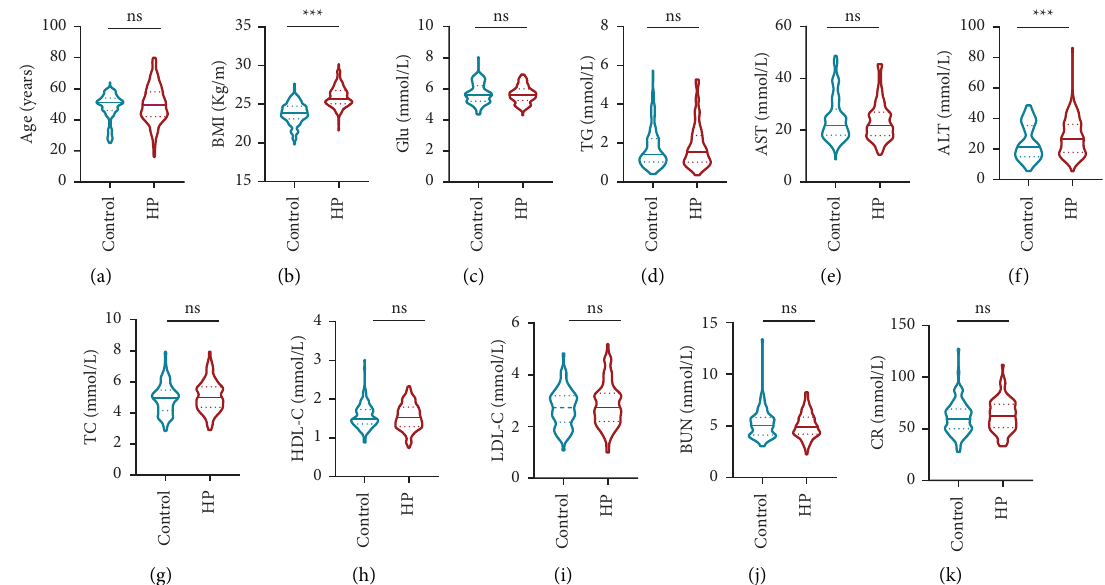
Figure 1: Te relevant assessment for various factors that might be associated with the therapeutic efect of irbesartan on controlling blood pressure. (a)–(k) Te comparisons of demographic characteristics including age (a), BMI (body mass index) (b), GLU (glucose) (c), TG (triglyceride) (d), AST (aspartate transaminase) (e), ALT (alanine transaminase) (f), TC (total cholesterol) (g), HDL-C (high-density lipoprotein cholesterol) (h), LDL-C (low-density lipoprotein cholesterol) (i), BUN (blood urea nitrogen) (j), and CR (creatinine) (k) between control and hypertensive patients (HPs).